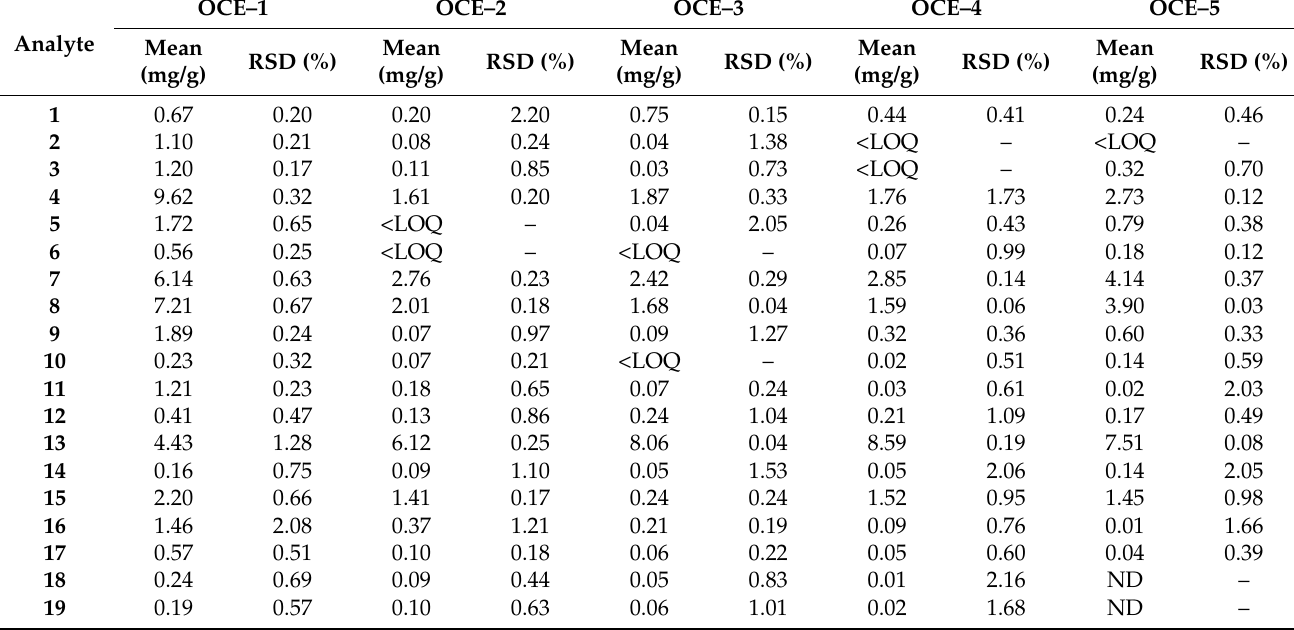
Table 4. Amounts of the 19 marker components in OCE samples ( n =